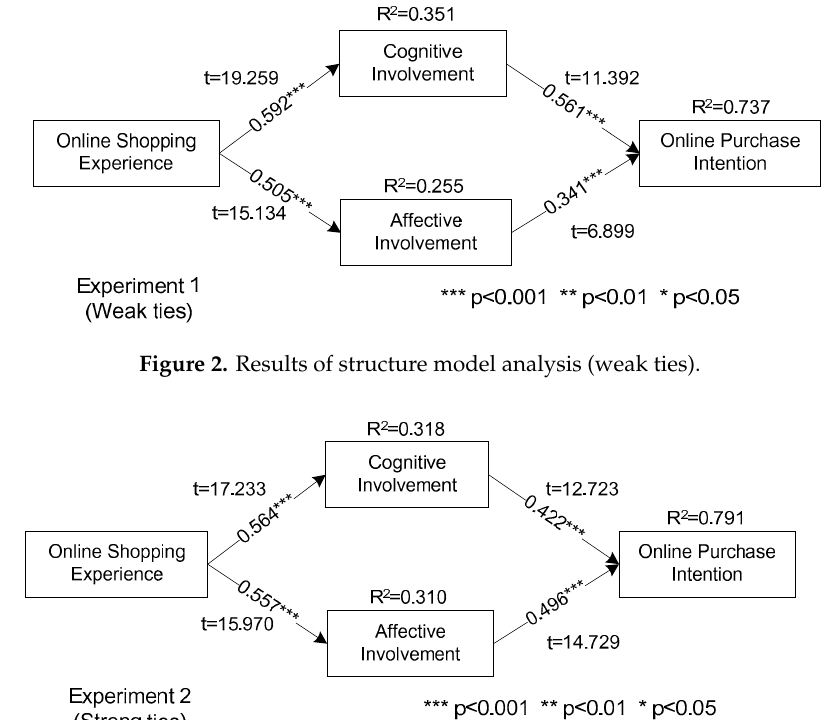
7 Table 4. Reliability and validity (strong ties). Items